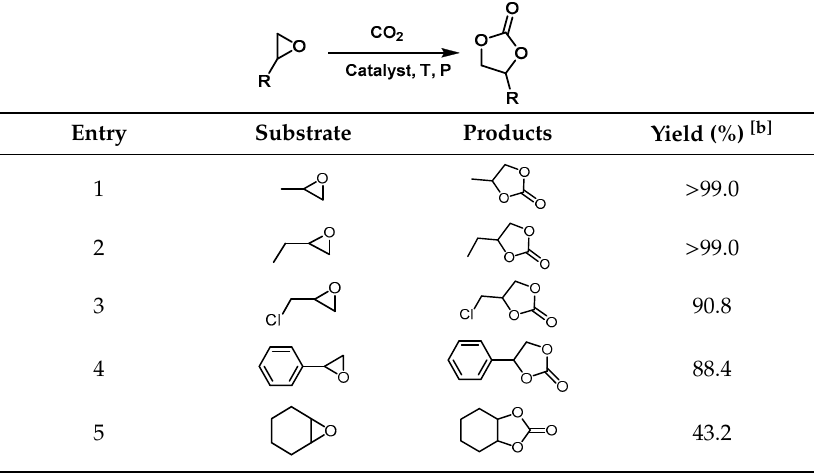
Table 2. Cyclo-addition of CO 2 with various substrates [a] .